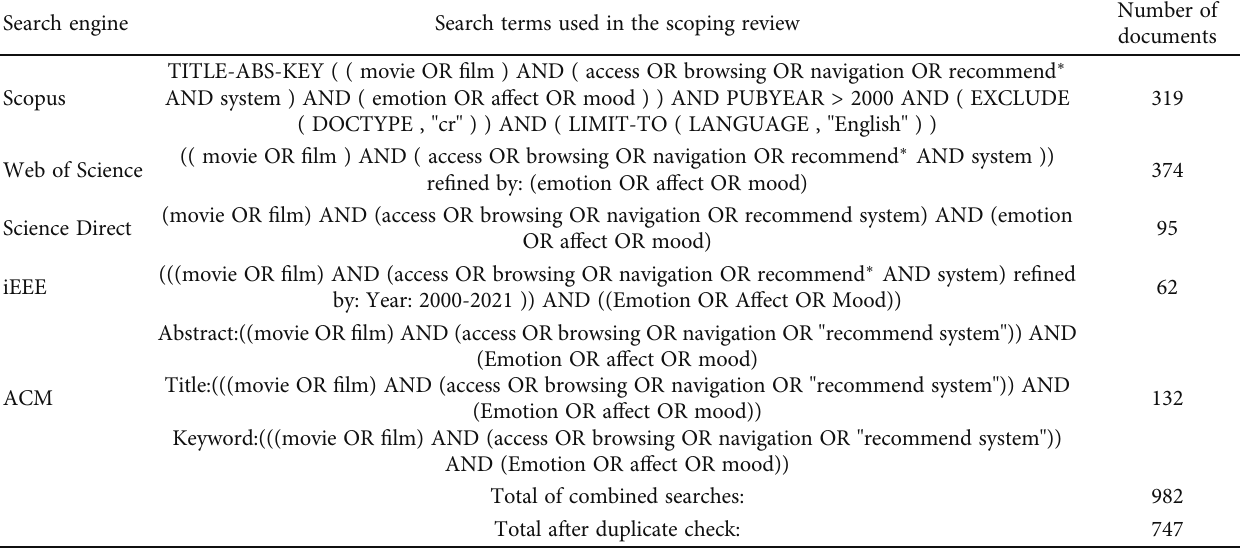
Table 1: Results of the Document Search and Keywords